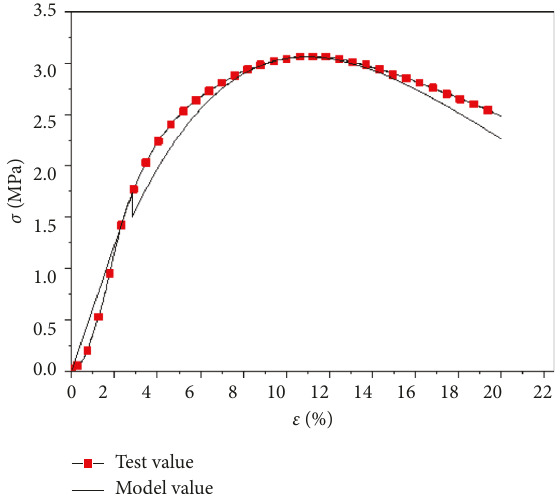
Figure 13: Comparison of model values and test values at − 10 °